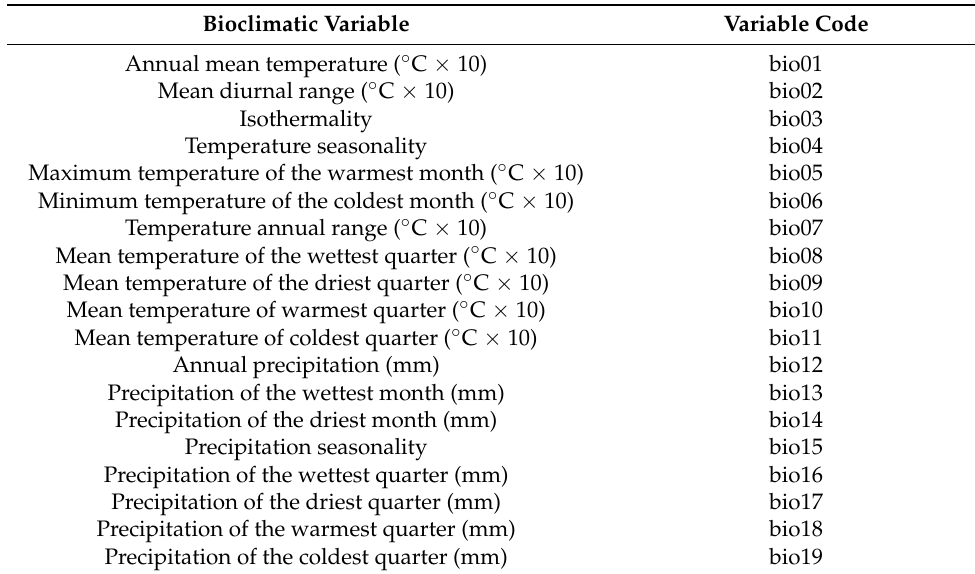
Table 2. Bioclimatic variables used in Maxent model development for Comperiella calauanica (after Hijmans et al.